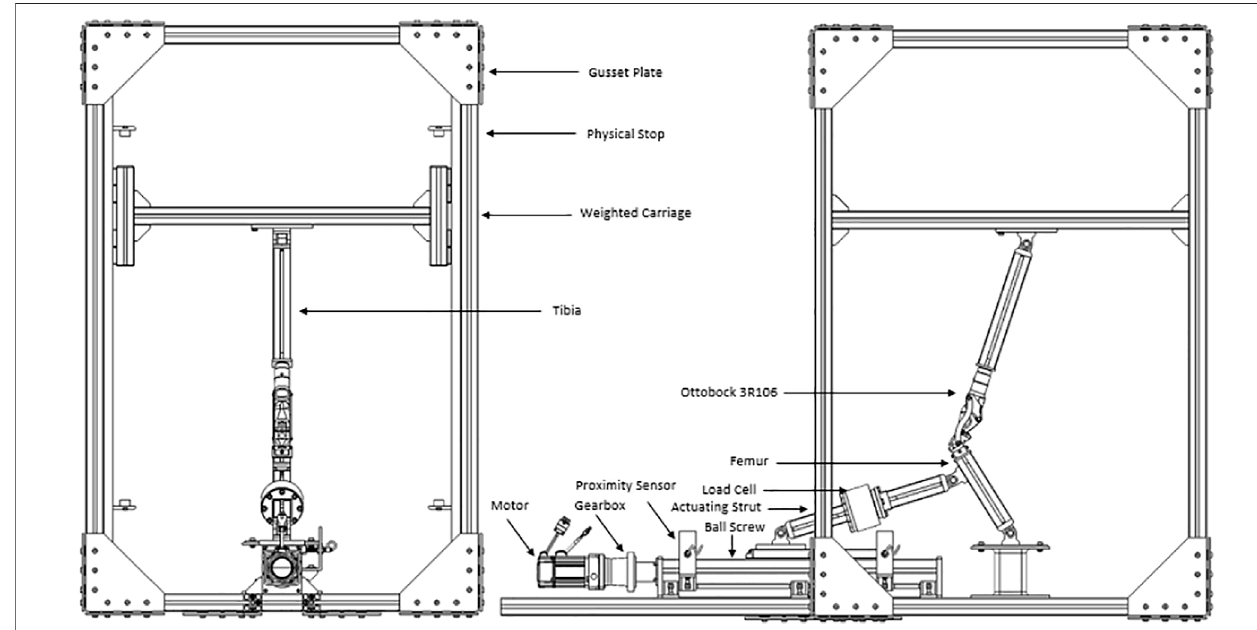
FIGURE 4 | Schematic of the mechanical components